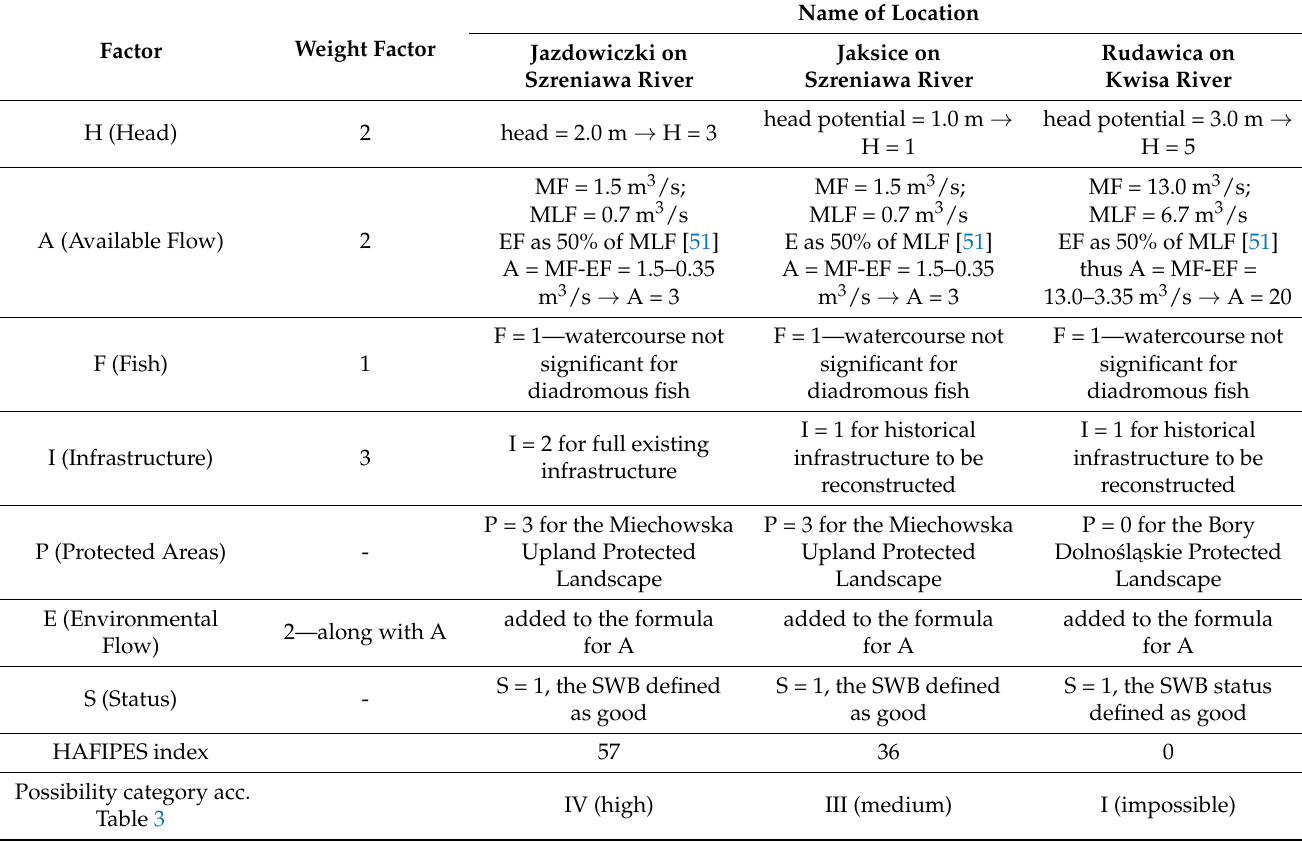
Table 4. Values of factors in the HAFIPES system for prospective